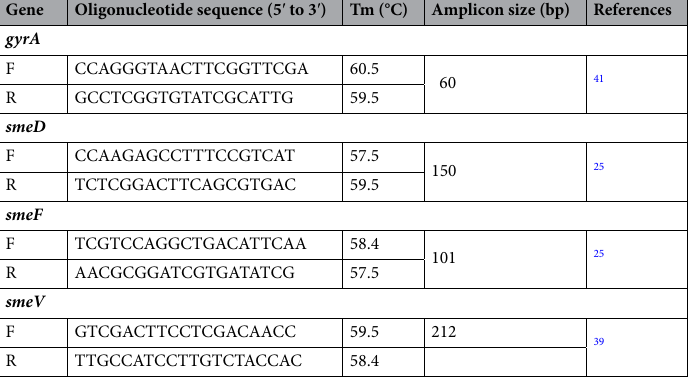
Table 3. Primers used in relative Rt qPCR for amplification of smeD , smeF , smeV , and gyrA genes in Stenotrophomonas maltophilia